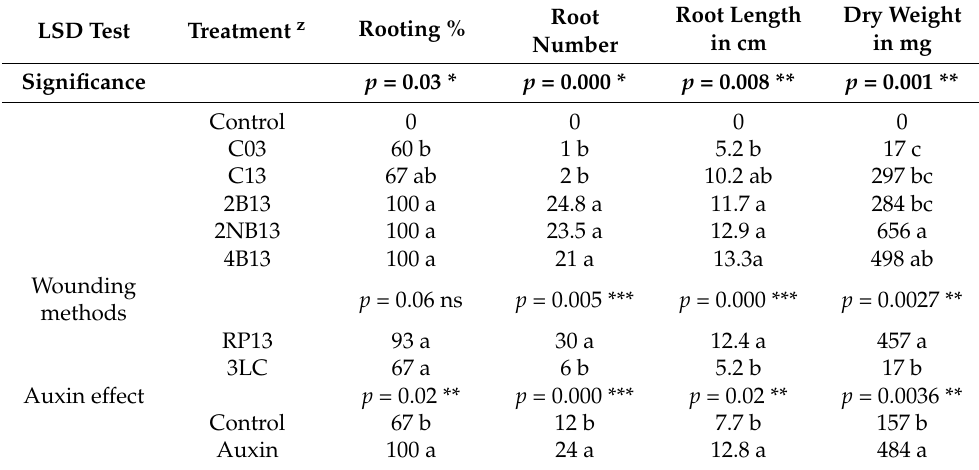
z Treatment description listed in Table